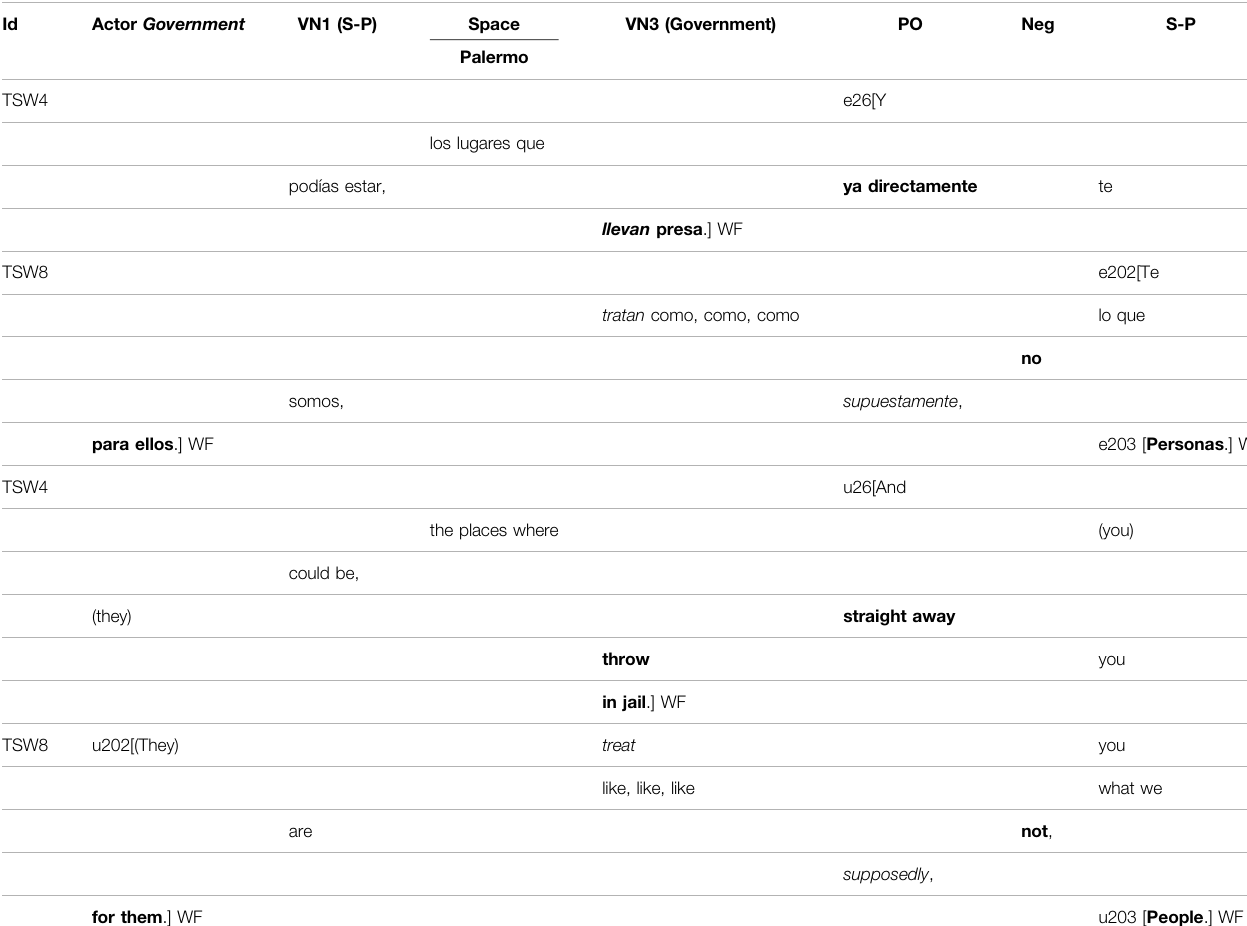
TABLE 11 | Reinforcement of institutional violence against transgender